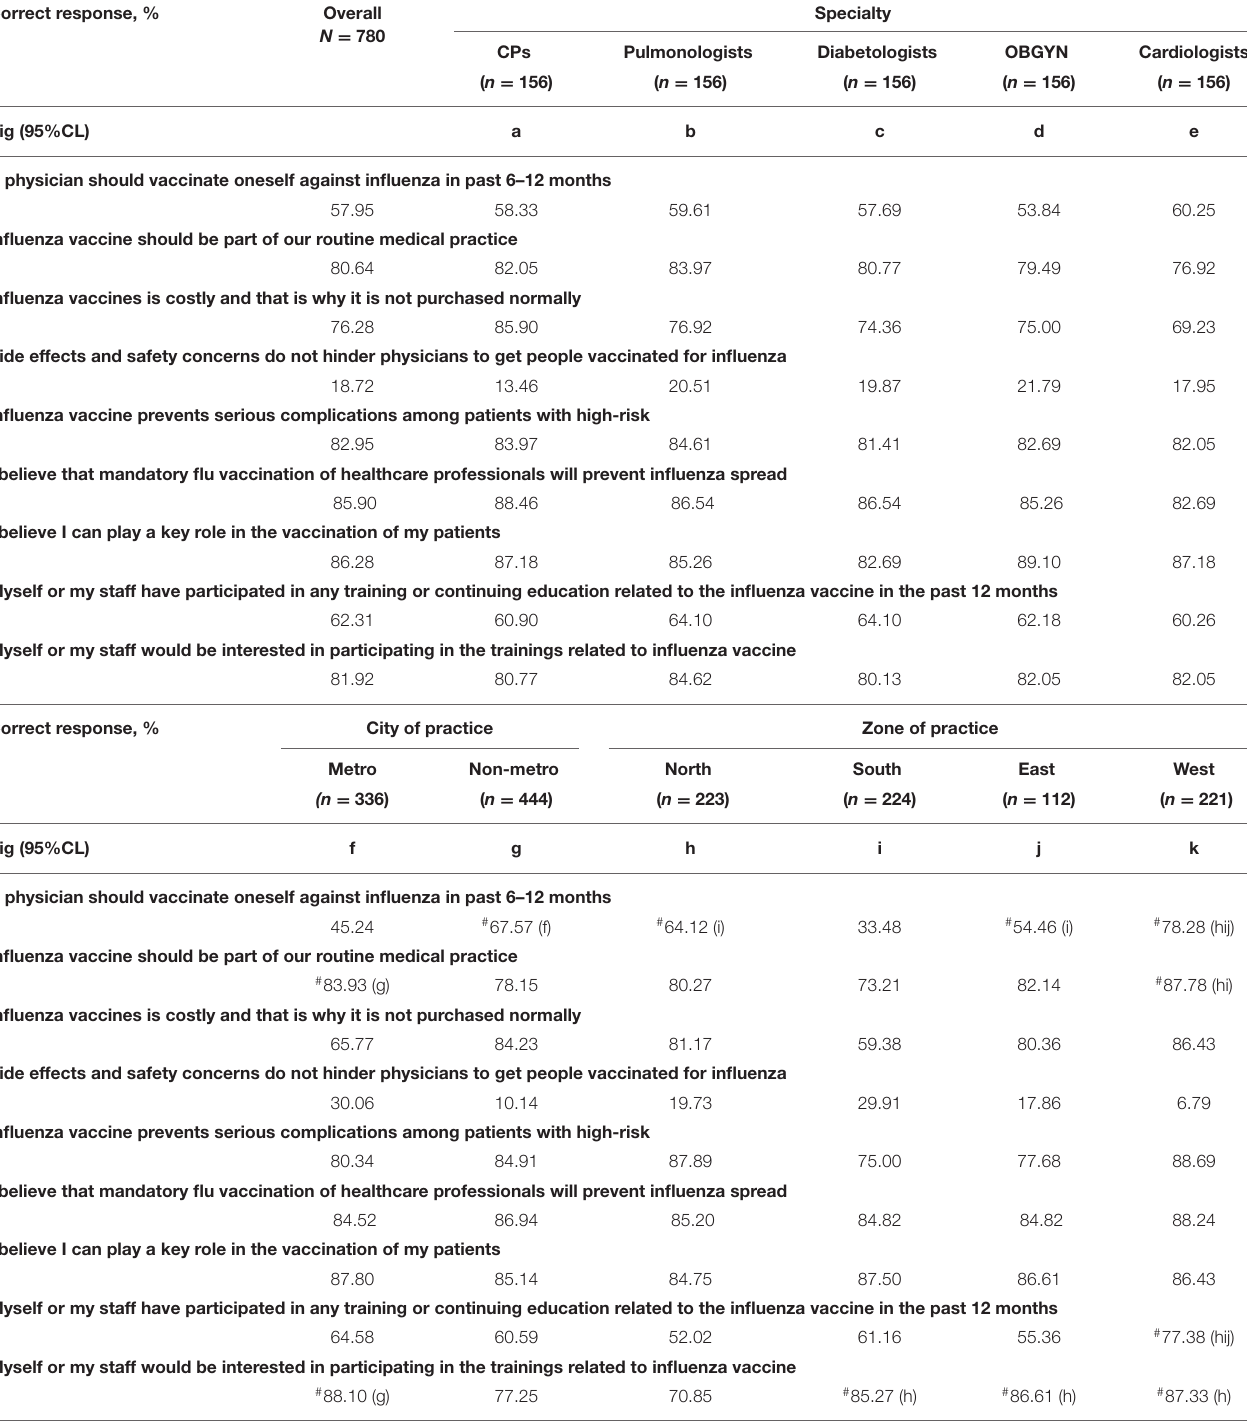
TABLE 3 | Physician attitude toward influenza vaccination. Correct response,